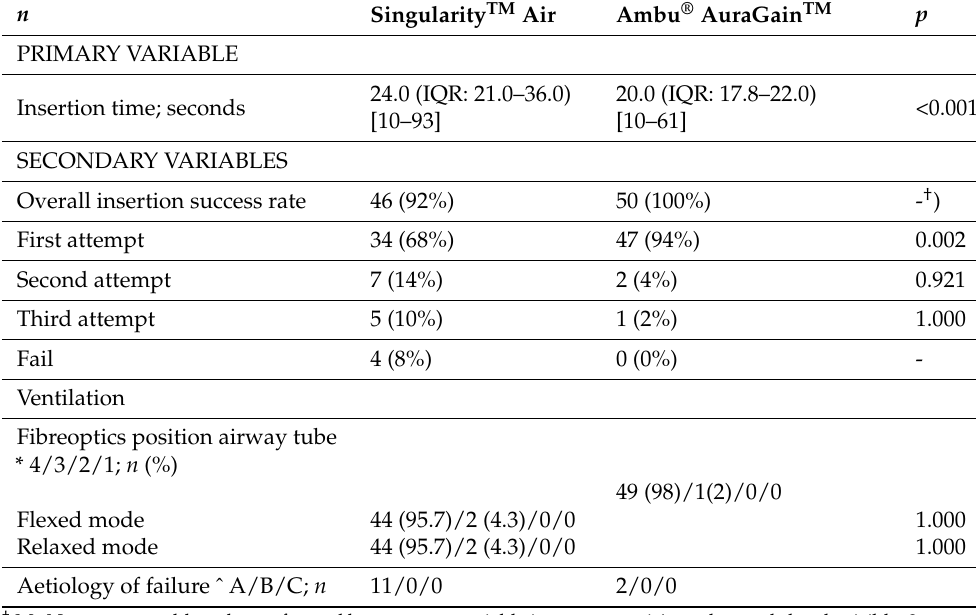
Table 2. Insertion success, insertion time, fibreoptic view to the glottic, aetiology of failed insertion, ease of insertion, insertion success rate for gastric tube, aetiology of failed insertion gastric tube. Data are mean or numbers